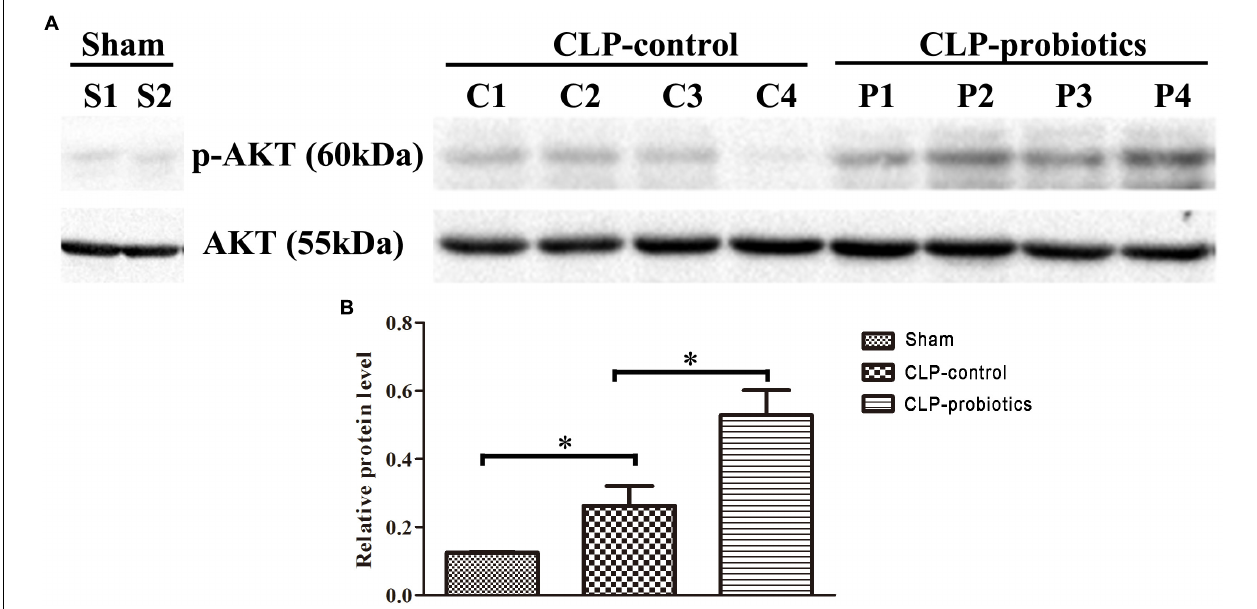
FIGURE 7 | The effect of LCBE pretreatment on p-AKT and total AKT expression in the ileal tissues of the septic mice. (A) Total AKT and phosphorylated AKT (p-AKT) in the ileal tissues of three groups were determined by Western blotting. (B) Relative levels (p-AKT/AKT) of each group were quantitatively analyzed. All data were illustrated as means ± SEM. N = 4 mice/group; ∗ P <